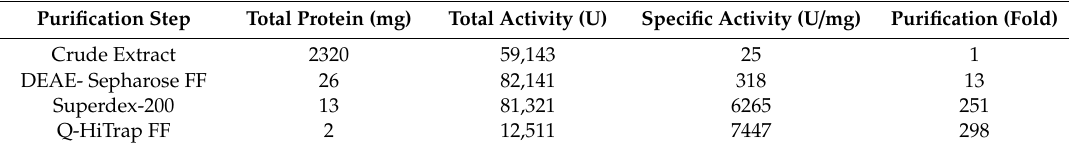
Table 3. Purification of catalase from I1P.